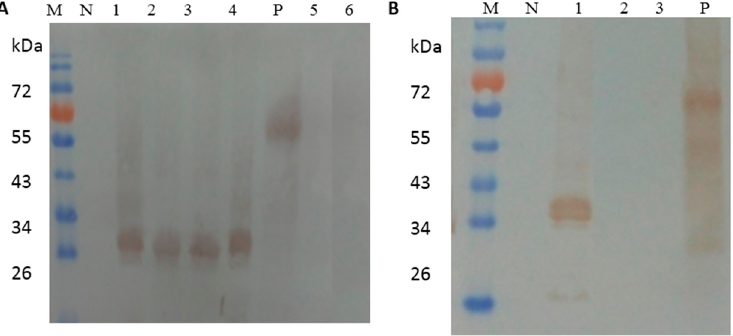
Figure 3. The reactivity of the synthesized mutations of the LD/NLPW ( A ) and YAEYI ( B ) peptides to duck anti ‐ duck Tembusu virus (DTMUV) serum by Western blot. YIRTPACWD and the E protein were used as the negative (N) and positive (P) controls, respectively. M: Protein marker; N: GST